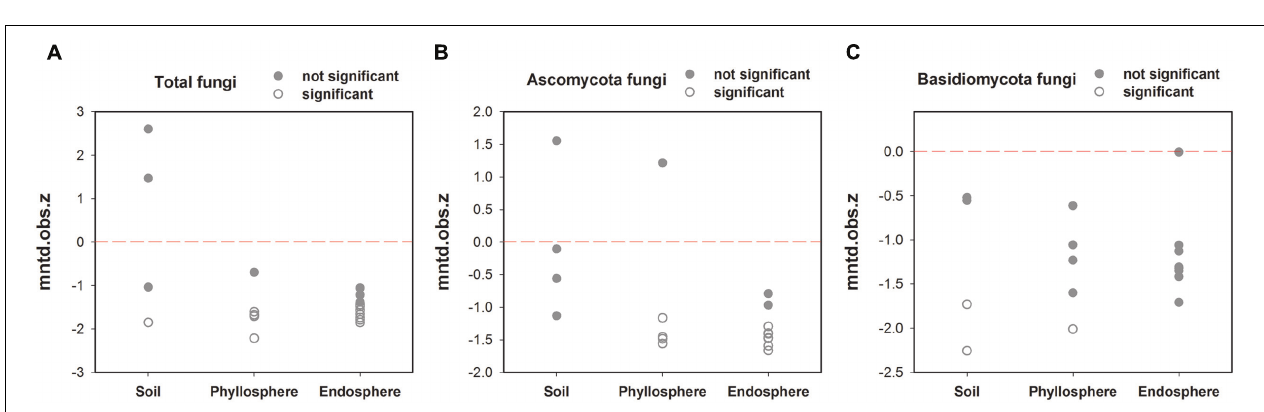
FIGURE 2 | Hierarchical clustering dendrogram of all samples. (A) Bary–Curtis dissimilarity based on incidence data, (B) Bary–Curtis dissimilarity based on abundance data, and (C) MNTD dissimilarity based on phylogenetic data. The sequences were subsampled to 1733 sequences per sample. Fungi 21 ∼ 30 belong to the endosphere, and are represented by light green leaves; Fungi 61 ∼ 66 belong to the phyllosphere, and are represented by dark green leaves; and Fungi 67 ∼ 70 belong to the soil, and are represented by dark soil.